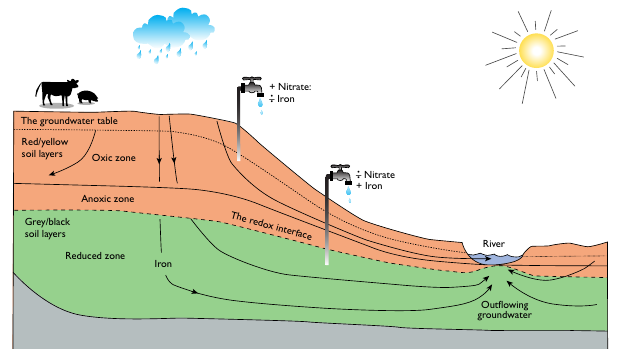
Table 1. Data used in the statistical analyses of nitrate in Danish groundwater.